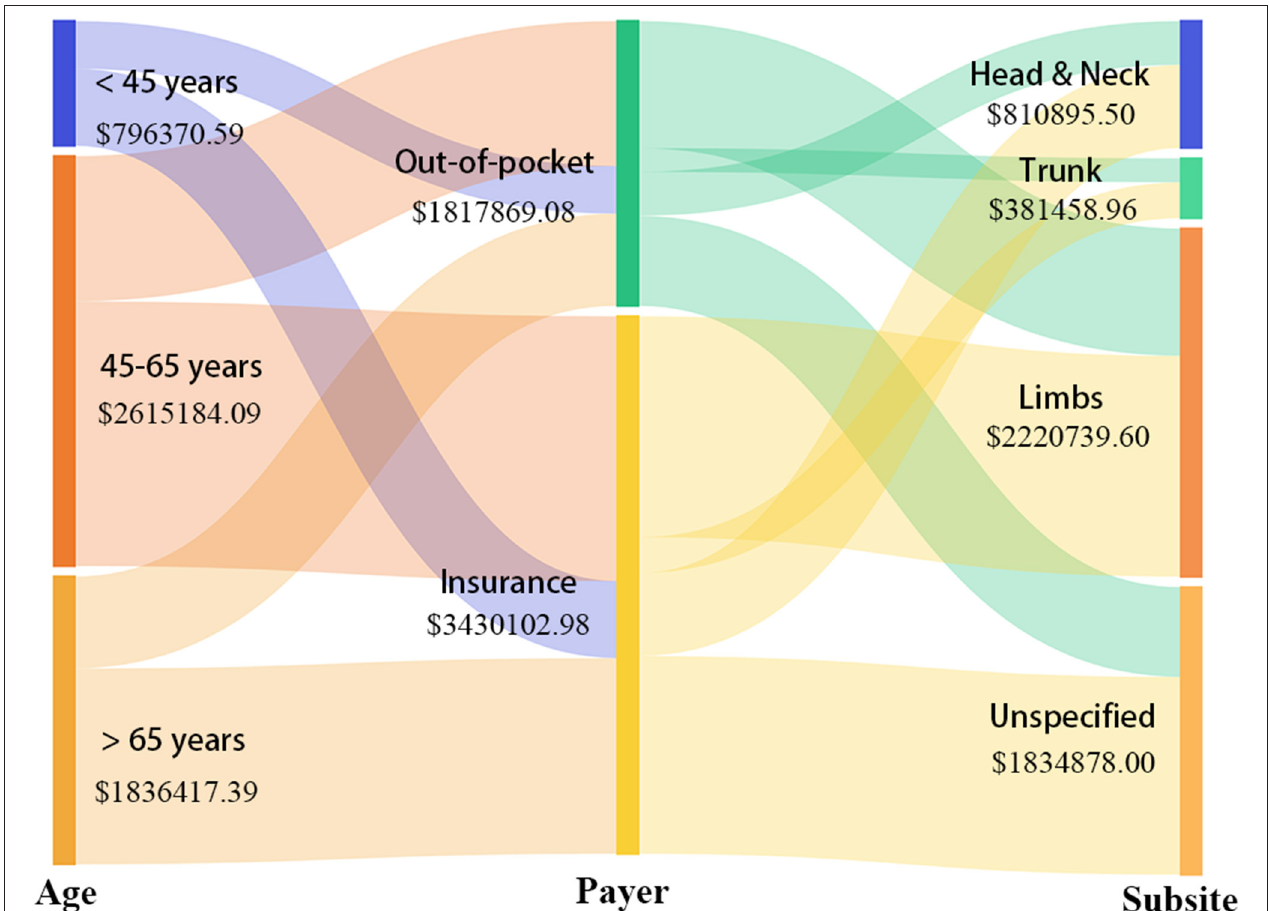
FIGURE 1 | Visualization of total costs for beneficiaries with different characteristics (age, payer, and